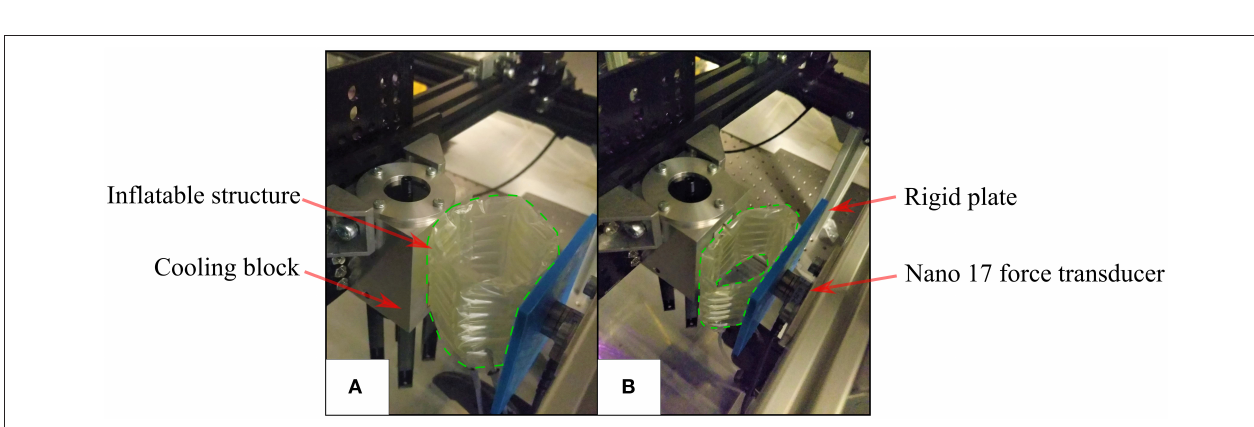
FIGURE 6 | Radial stiffness measurement setup (A) the initial position where the Aluminum block is in contact with the inflatable structure (enclosed by green dashed line) (B) the inflatable structure deflecting and exerting force on the force transducer during testing.